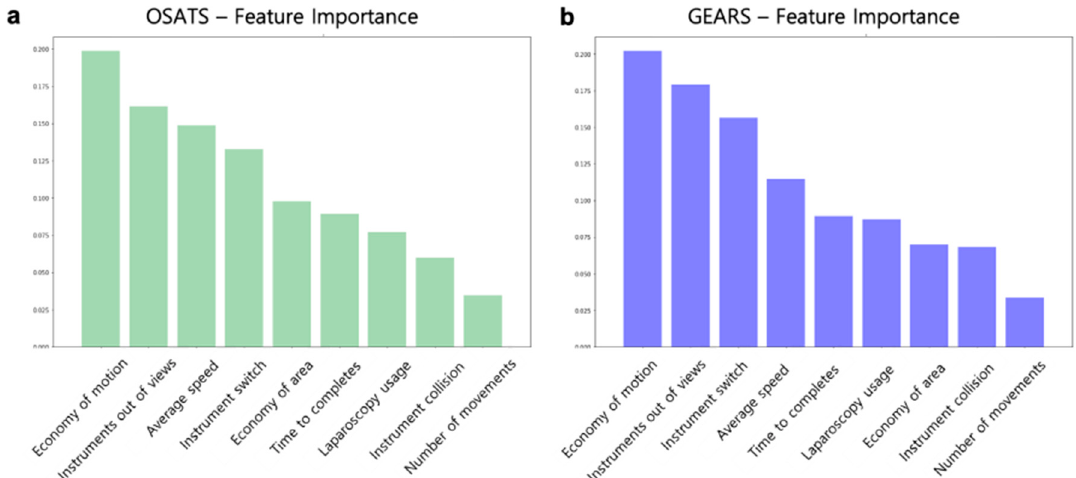
Figure 6. Relative importance of motion metrics in surgical skill prediction models. ( a ) Importance of motion metrics in Object Structured Assessment of Technical Skills (OSATS). ( b ) Importance of motion metrics in Global Evaluative Assessment of Robotic Surgery (GEARS).